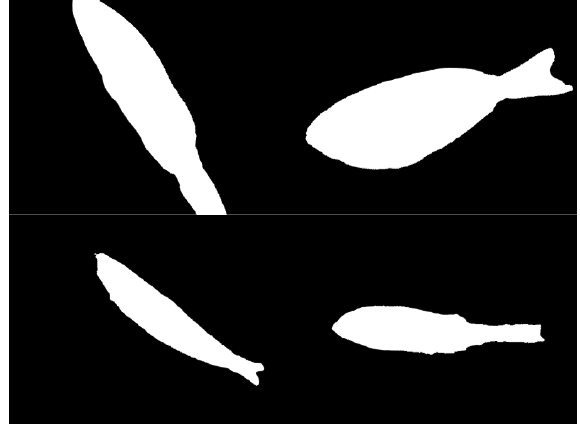
Figure 10. The segmentation results of FCN16s.